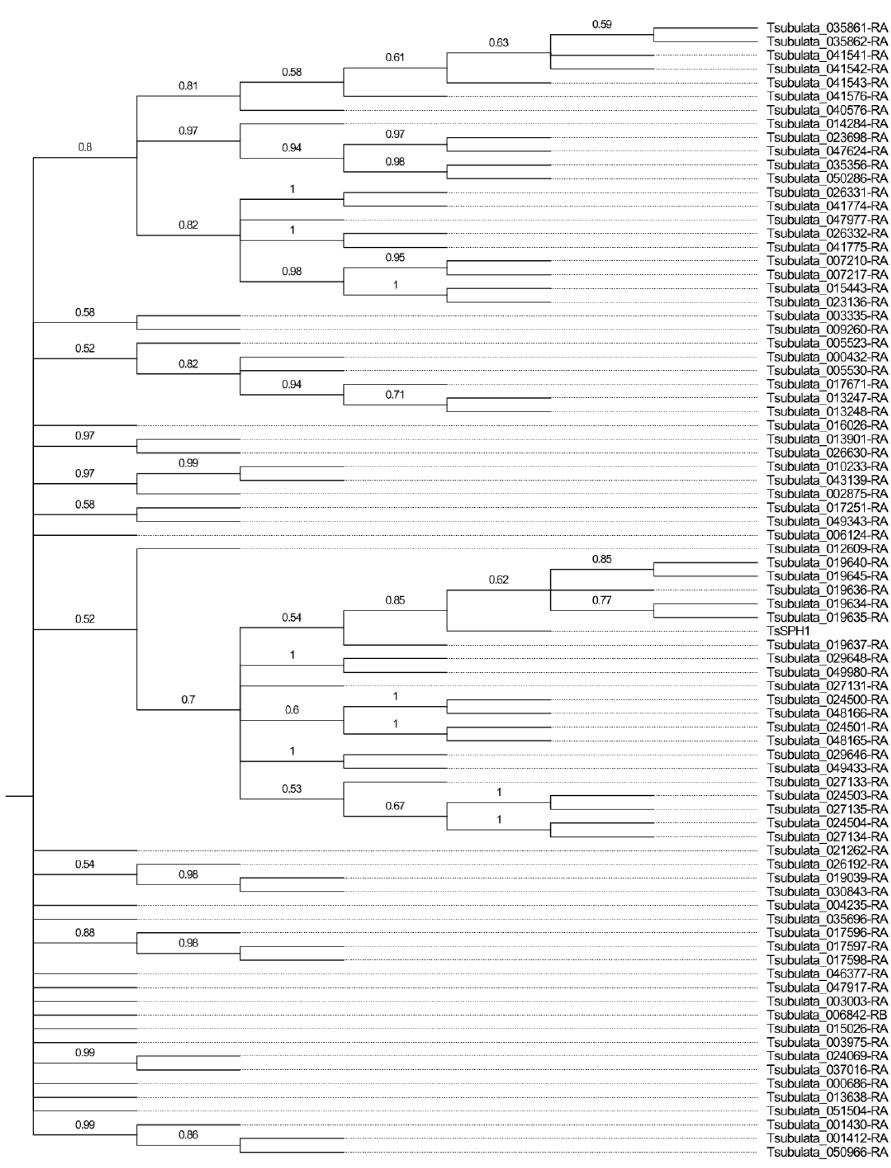
Figure 6. Phylogenetic relationships of the SPH gene family in Turnera subulata . Generated using MEGA11 [30]. Values at nodes represent proportions from 1000 bootstrap replicates. Additional information related to motifs and intron/exon structure can be found in Supplementary Figure S8.